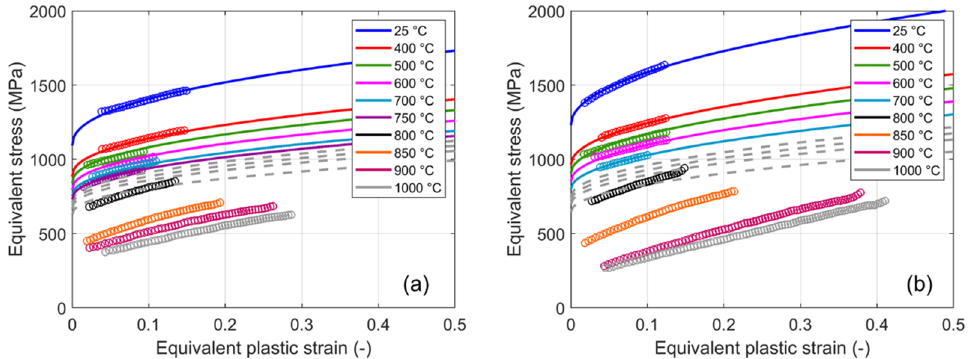
Figure 16. Comparison between the experimental results in terms of equivalent stress versus equivalent plastic strain obtained from the engineering data (markers) and the fitting models (lines): ( a ) DA specimens and ( b ) HT specimens. The dashed lines represent the model predictions obtained for higher temperatures (model extrapolation).